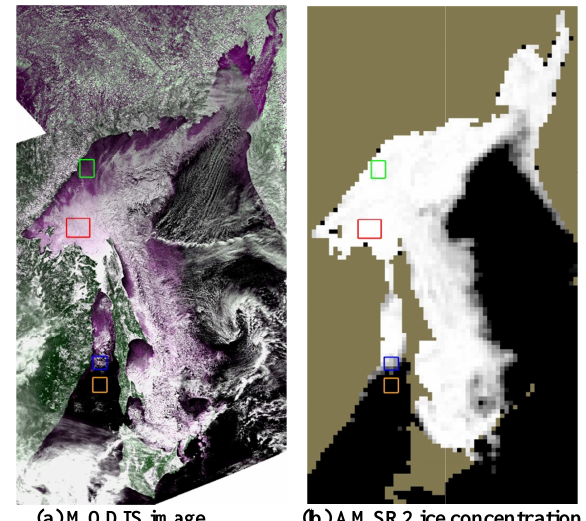
Figur Figur e 2 . Comparison of AMSR2 and MODIS images. (Sea of Okhotsk,